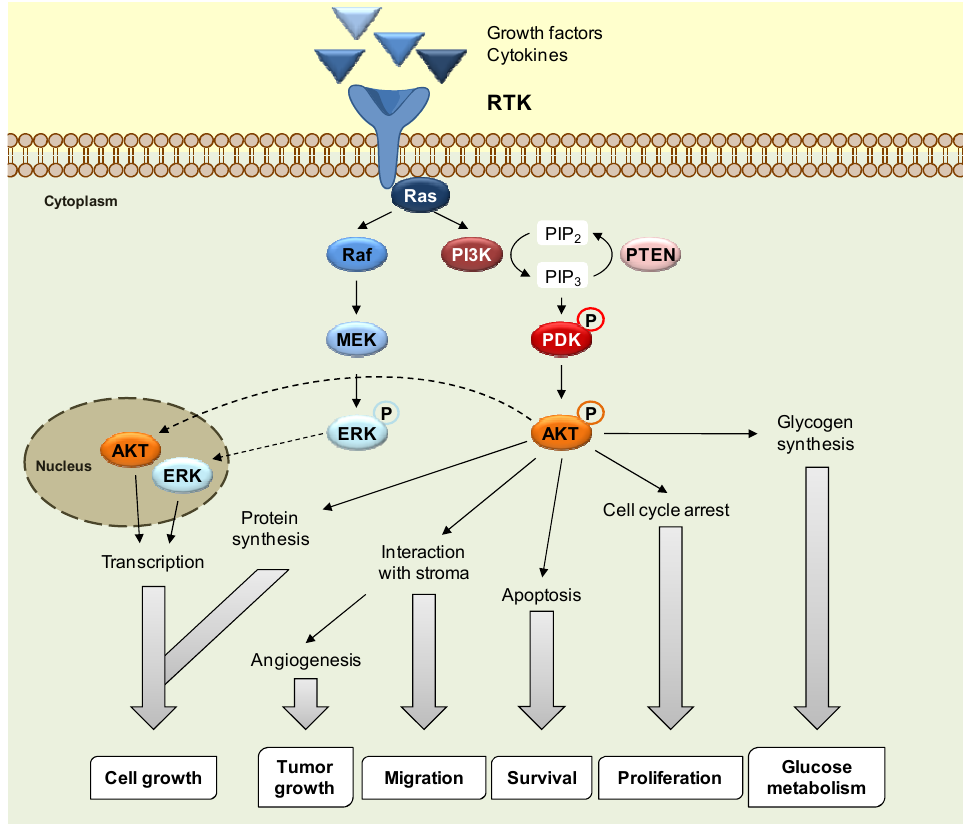
Figure 1. Schematic overview of the key cellular signaling pathways that are commonly affected by oncogenic alterations and may be targets for